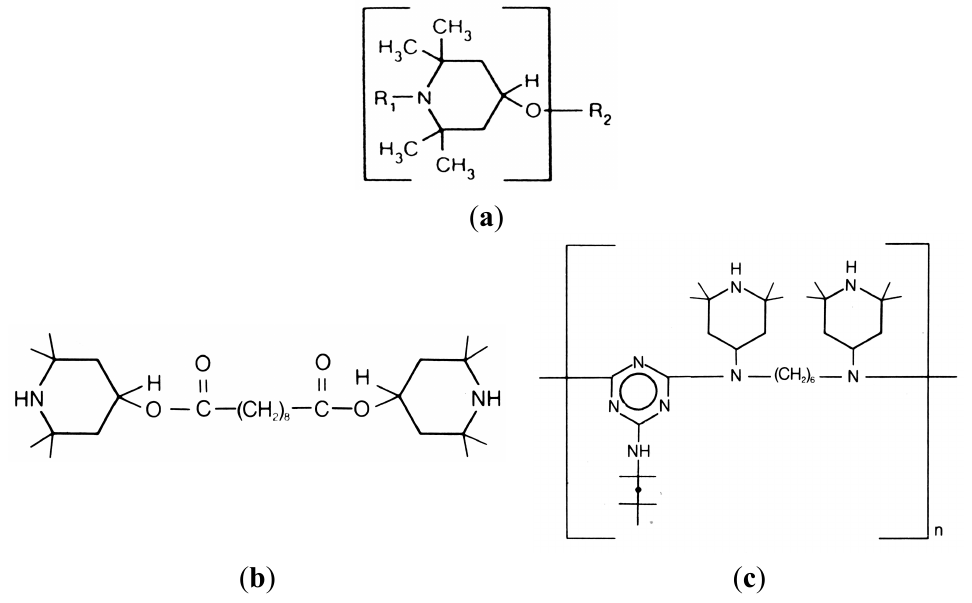
Figure 6. Generalized structures of hindered amine light stabilizers (HALS): ( a ) 2,2,6,6-tetramethyl piperidine; ( b ) Low molecular weight HALS; ( c ) Oligomeric